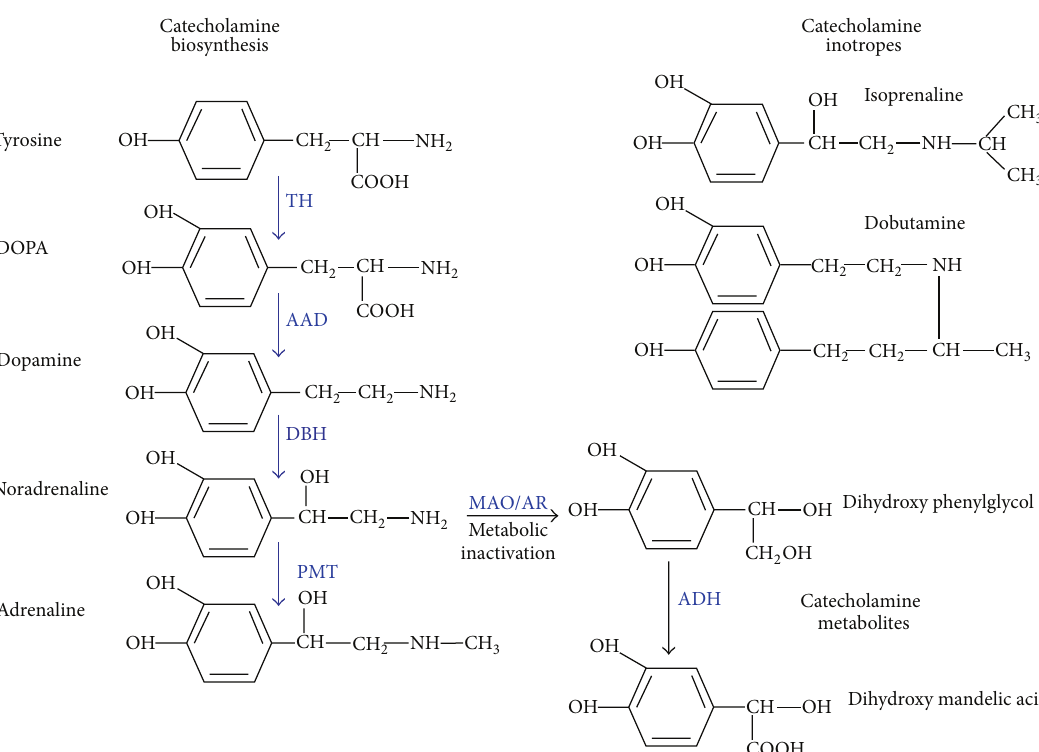
Figure 1: Structures of catecholamine stress hormones, inotropes, and their metabolites. The figure shows the pathway of catecholamine synthesis; it should be noted that for clarity the various cofactors utilised in the pathway are not shown. In mammals, dopamine is synthesized from L-dopa, obtained from dietary sources (such as the amino acids tyrosine and phenylalanine) [15]. Synthesis of catecholamines is to a degree tissue specific; for example, phenylethanolamine N-methyltransferase, which is required for adrenaline synthesis, is not expressed in cells of the enteric nervous system [15, 16]. Catecholamine biosynthesis, TH: tyrosine hydroxylase, AAD: aromatic L-amino decarboxylase, DBH: dopamine 𝛽 -hydroxylase, PMT: phenylethanolamine N-methyltransferase. Metabolic inactivation: MAO: monoamine oxidase, AR: aldehyde reductase, ADH: aldehyde dehydrogenase. This figure was adapted with permission from Freestone et al. (2008) [3].